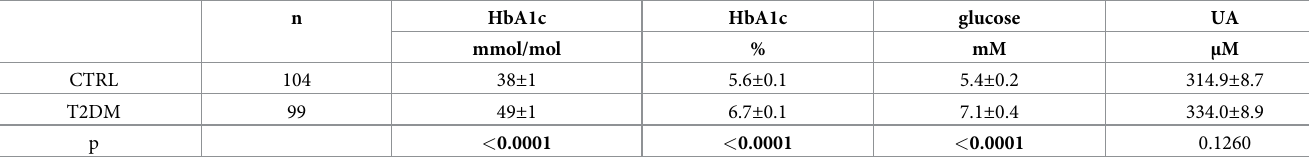
Table 1. Summary of some key data for age-matched control subjects and the T2DM patients.